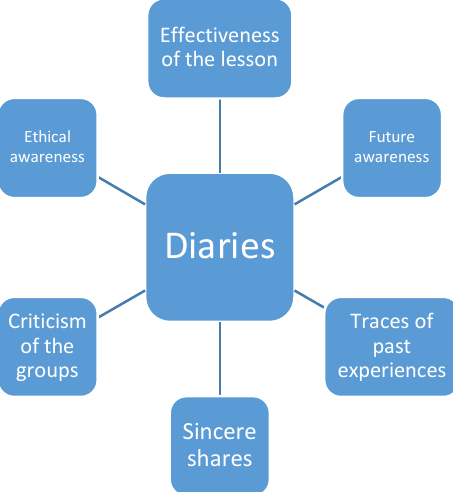
Figure 1 . Outstanding situations in the analysis of the diaries